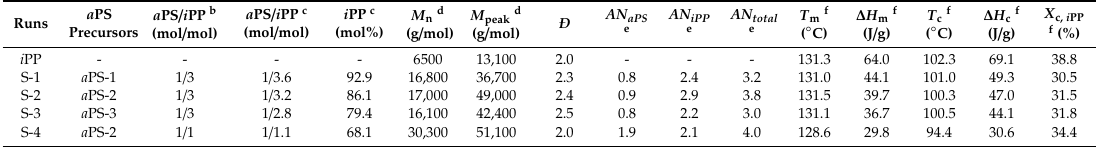
Table 2. Synthesis and characterization of i PP / a PS miktoarm star copolymers a .